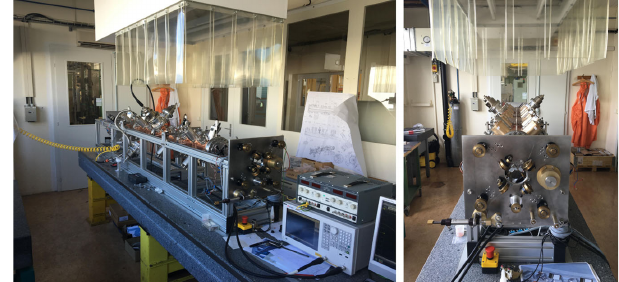
FIG. 2. The picture shows the bead pull measurements setup of like VNA (vector network analyser) and power supply for the motor that drives the wire.